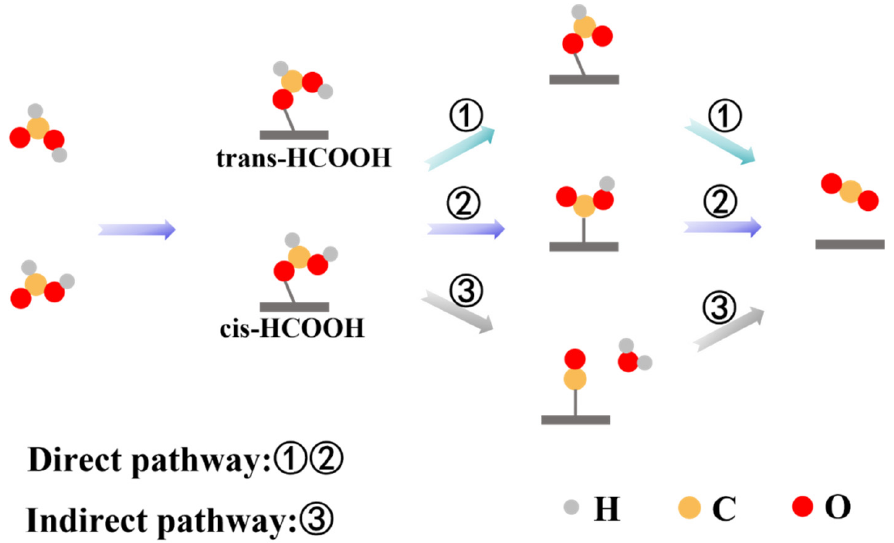
Figure 3. Schematic illustration of the direct pathway and indirect pathway mechanisms for FAOR on TM/g–CN.